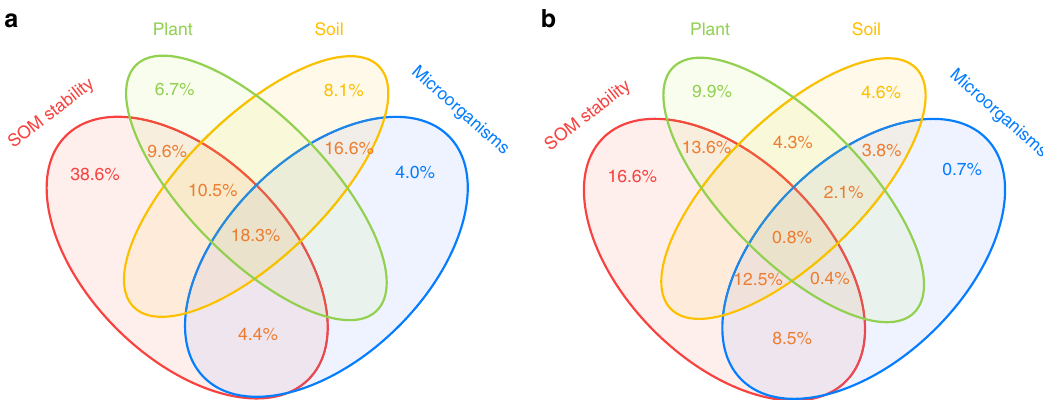
Fig. 3 Relative contributions of soil organic matter stability, plant, soil and microbial properties to the priming effect. Variation partitioning analysis was conducted to identify the variance in the absolute priming effect ( a ) and relative priming effect ( b ) explained by these four groups of biotic and abiotic factors. SOM, soil